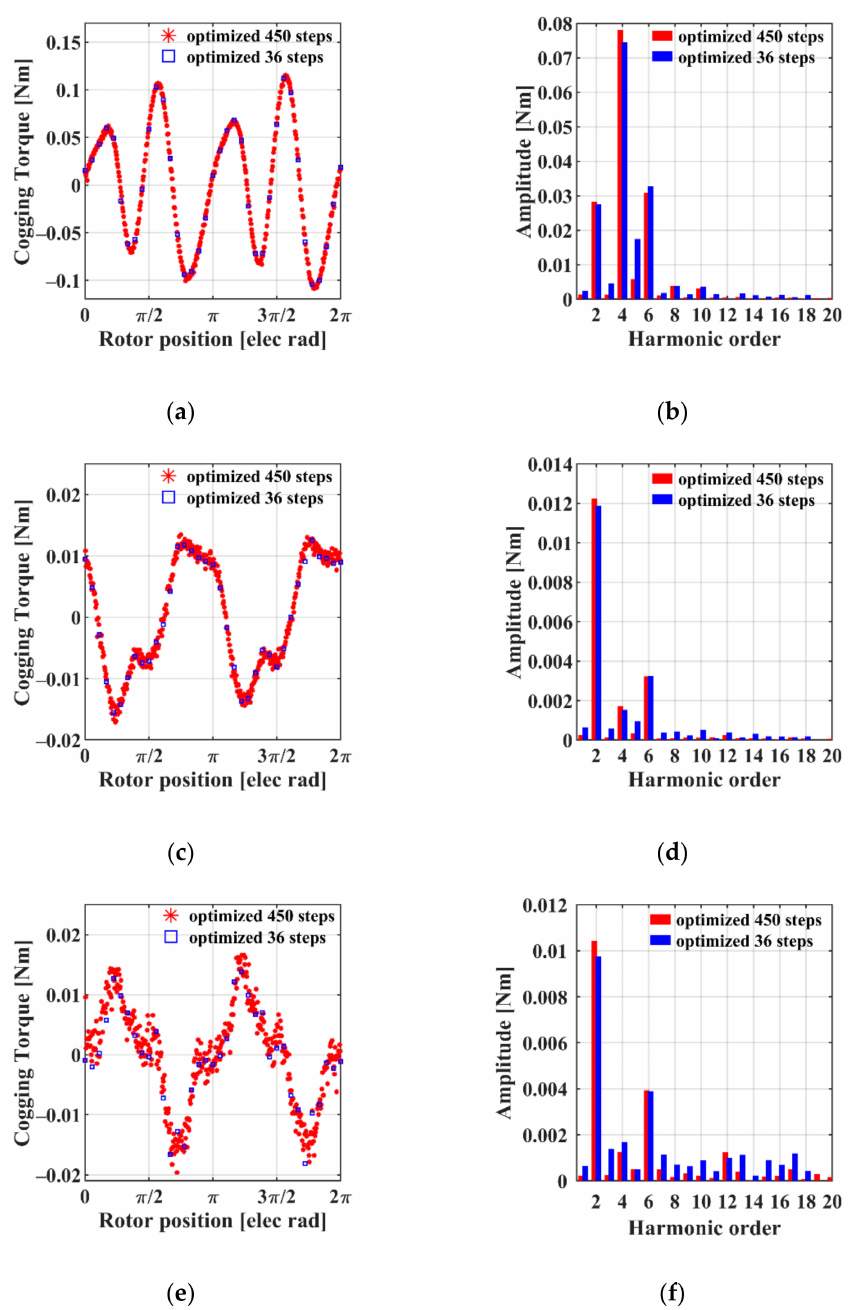
Figure 9. Cogging torque waveforms and harmonic spectra of the optimized APMMs. ( a , b ) APMM with 20 stator segments. ( c , d ) APMM with 30 stator segments. ( e , f ) APMM with 60 stator